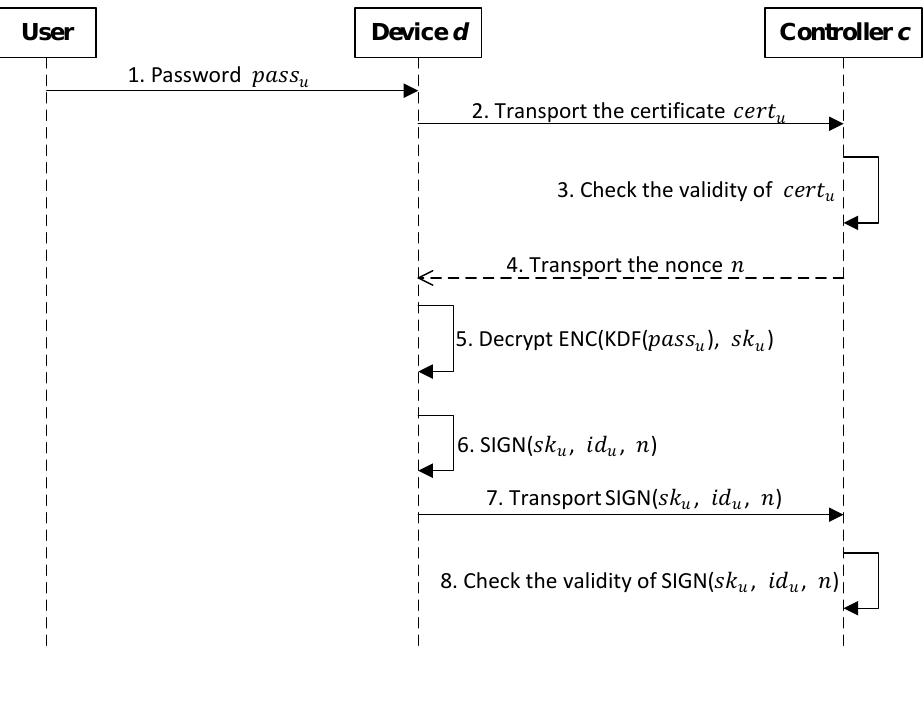
Figure 1. User authentication using a digital